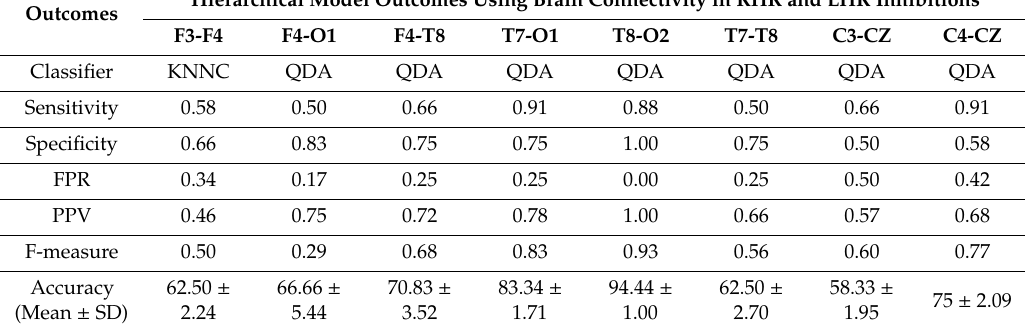
Table 3. Summary of sensitivities, specificities, false positive rate (FPR), positive predictive value (PPV), F-measure and accuracy (%) outcomes during RHR (SS) vs. LHR